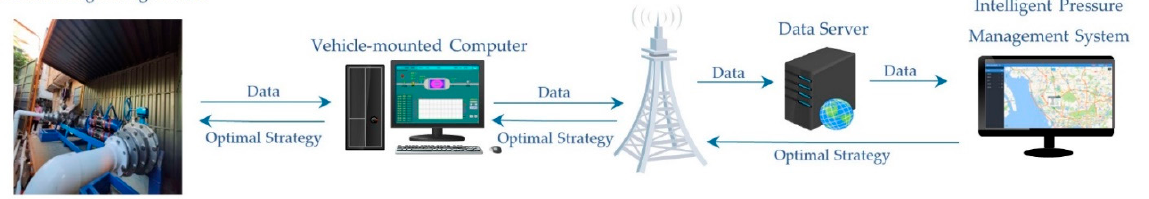
Figure 2. Concept of the IPRV.